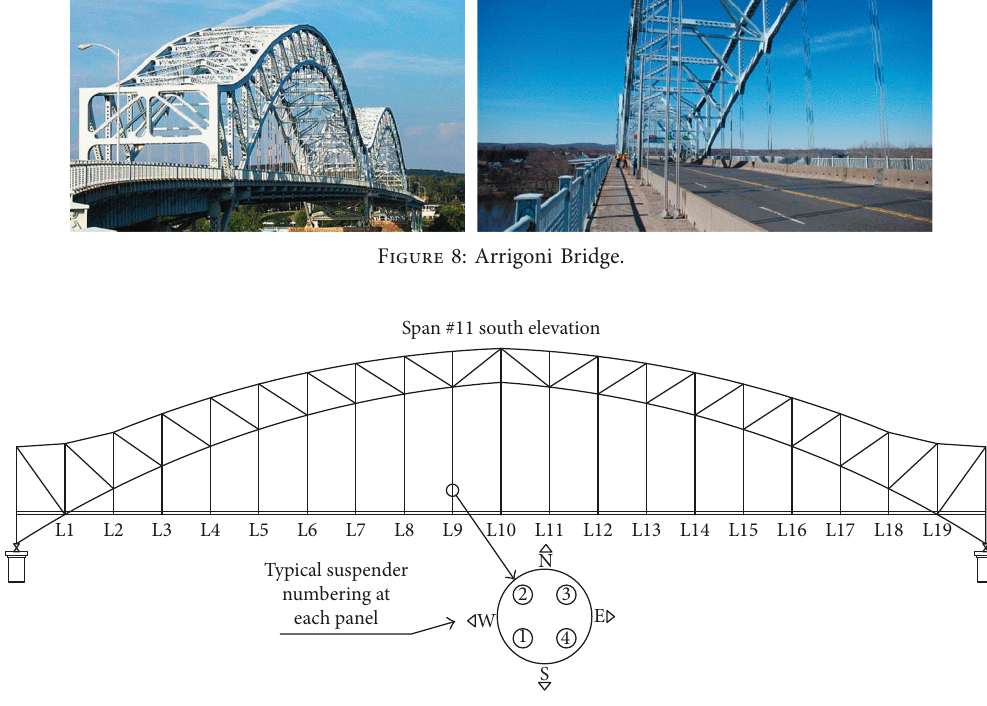
Figure 9: Suspender cable